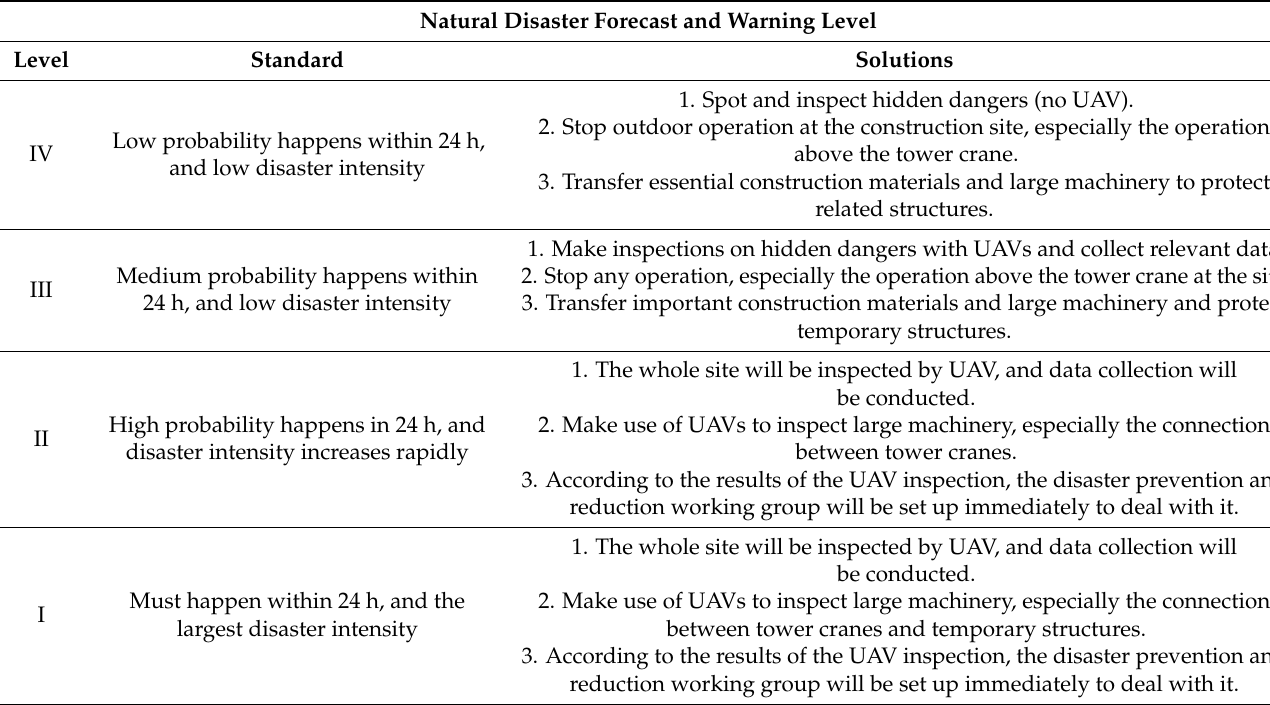
Table 11. The measures of disaster prevention and